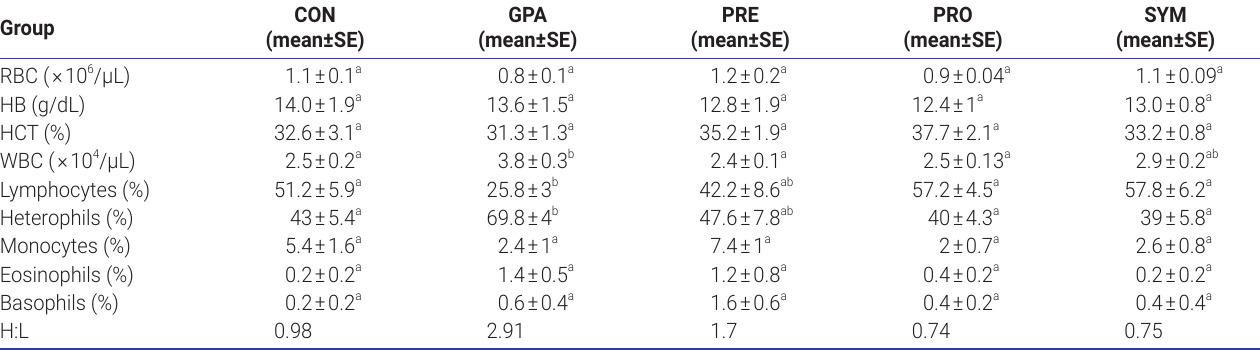
Table 4. Effect of the inclusion of encapsulated additives on the hematological parameters in birds at the end of the experiment